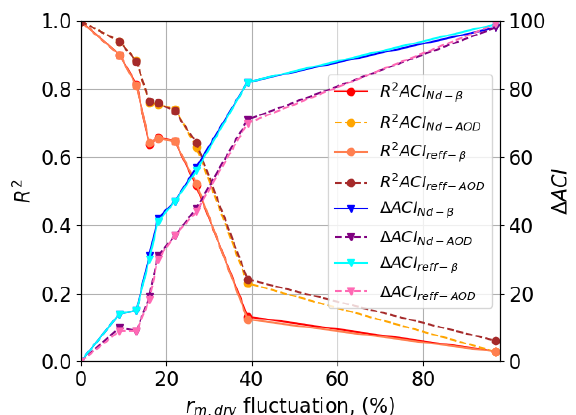
Figure 12. Correlation coefficients ( R 2 ACI ) and variability ( ∆ ACI) for ACI Nd − β and ACI ref f − β as a function of the fluctuation of the aerosol modal radius at surface ( r m , dry ) using LARSS.